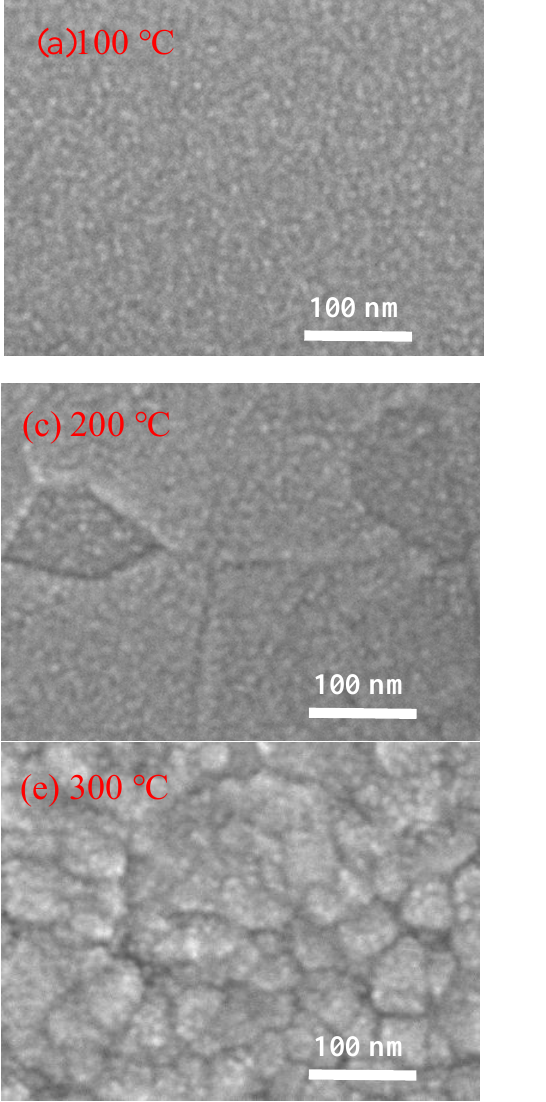
Figure 5 . Field-emission scanning electron microscope (FESEM) images of PEALD-In 2 O 3 films deposited at a substrate temperature of ( a ) 100 °C; ( b ) 150 °C; ( c ) 200 °C; ( d ) 250 °C; ( e ) 300 °C; and ( f ) 350 °C